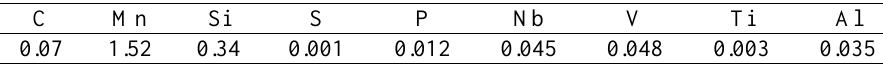
Table 1. Chemical composition of X70 steel